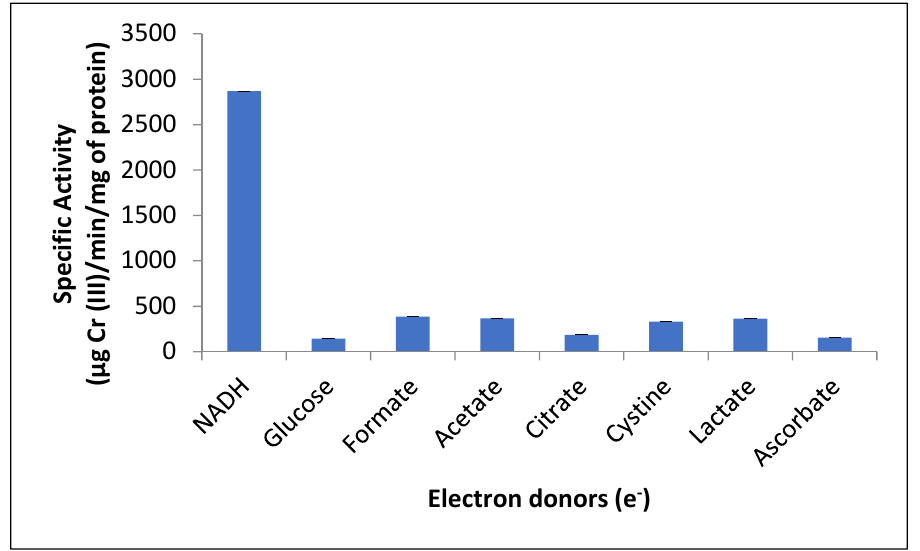
Figure 7. Effect of electron donors on crude reductant activity in the mixed membrane fraction of Purpureocillium lilacinum . 1 h of incubation, pH 7.0, 100 rpm, and 37 °C.